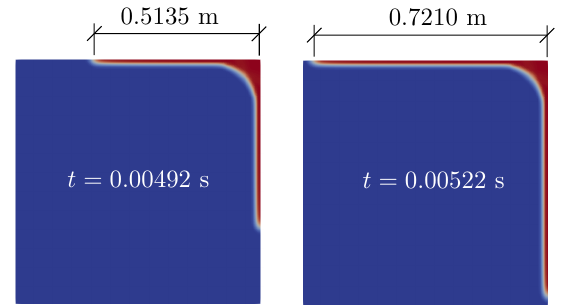
Figure 9. Crack development in two different time instants for mesh M1 100 ×